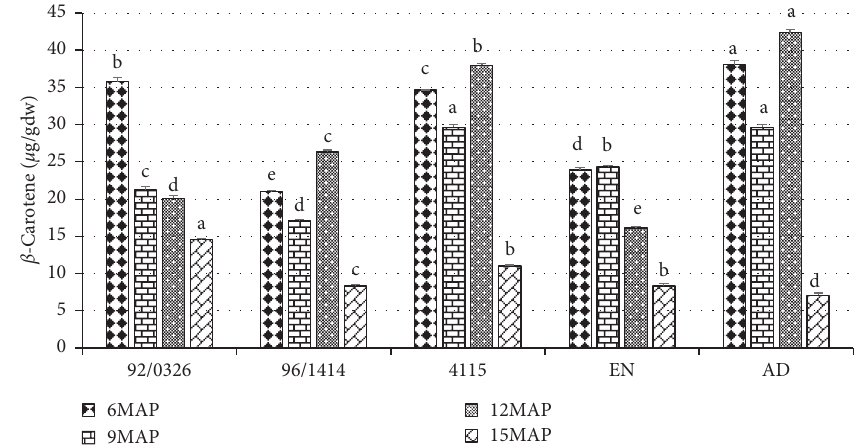
Figure 2: β -Carotene content of edible cassava leaf variety at different harvest ages. Values are given in micrograms per gram of sample dry weight ( μ g/gdw); MAP: months after planting. Cassava leaves varieties were harvested at 6MAP (onset of dry season, 15–20 ° C, 00 mm), 9MAP (main dry season, 35–40 ° C, 00mm), 12MAP (onset of rainy season, 20–30 ° C, 300–500mm), and 15MAP (rainy season, 15–25 ° C, 9500–1100mm) months after plantation. Values are expressed in microgram per gram dry weight basis ( μ g/gdw). Values are mean- ± standard deviation; n � 3; bars followed by different lowercase letters are significantly ( p < 0 . 05) different for the same harvest age. Two- way ANOVA: variety ( p value � 0.050); MAP ( p value � 0.000); variety × MAP ( p value �